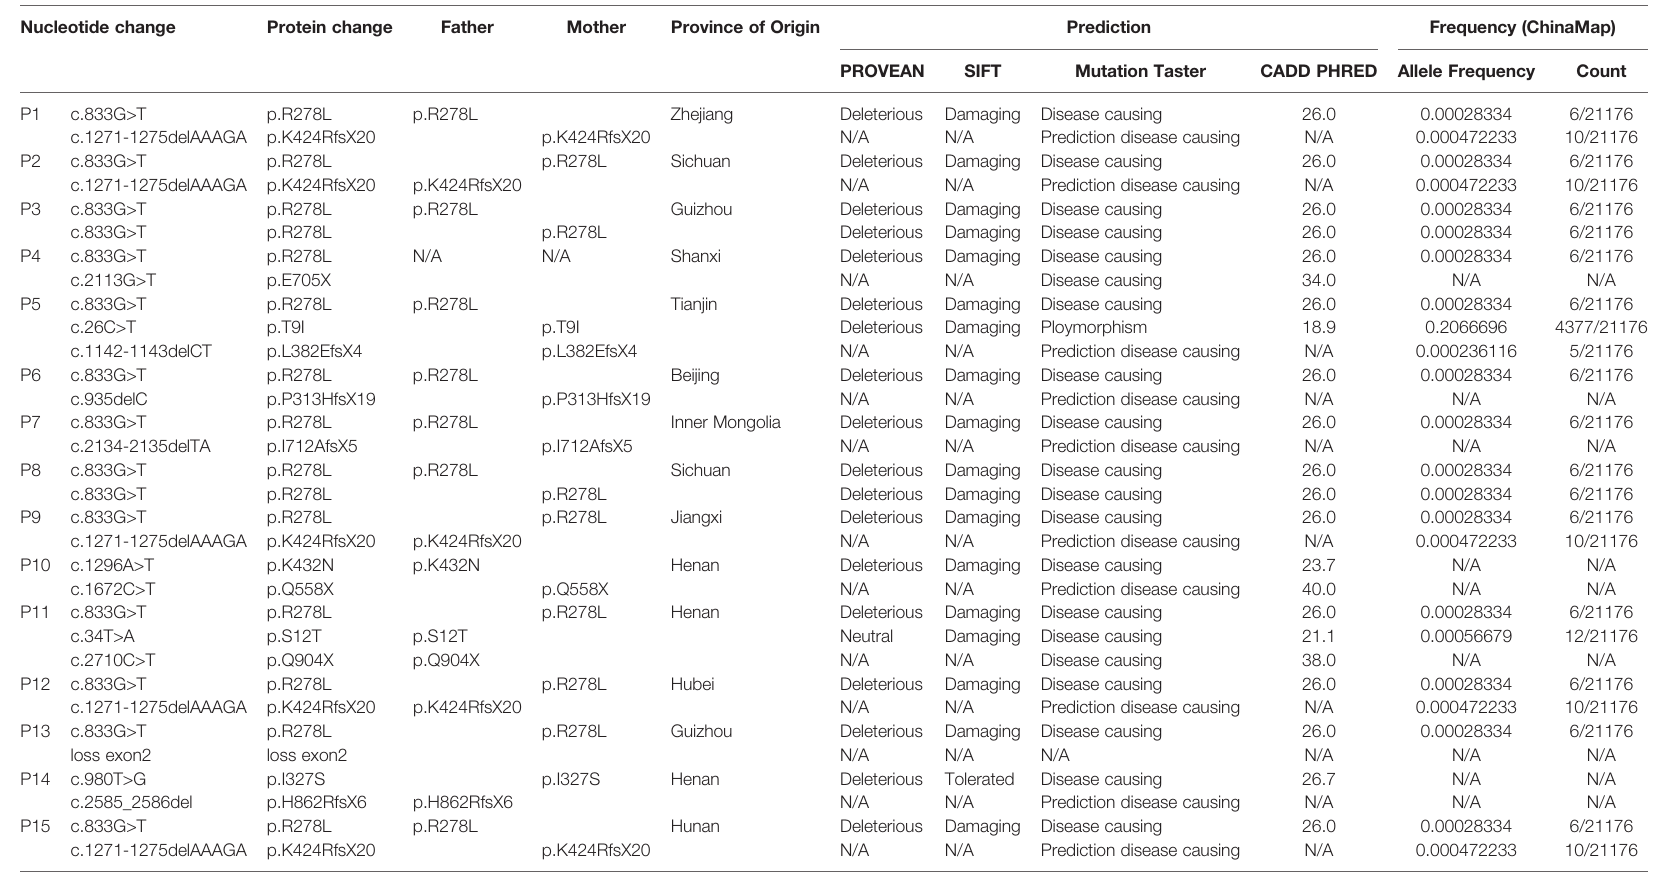
TABLE 2 | Genetic